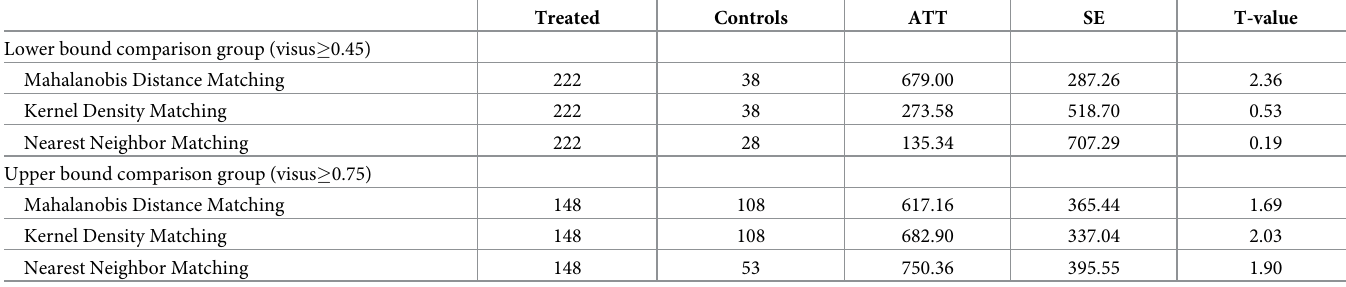
Table 7. ATT’s for MDM, KBM and NNM with upper and lower bound comparison